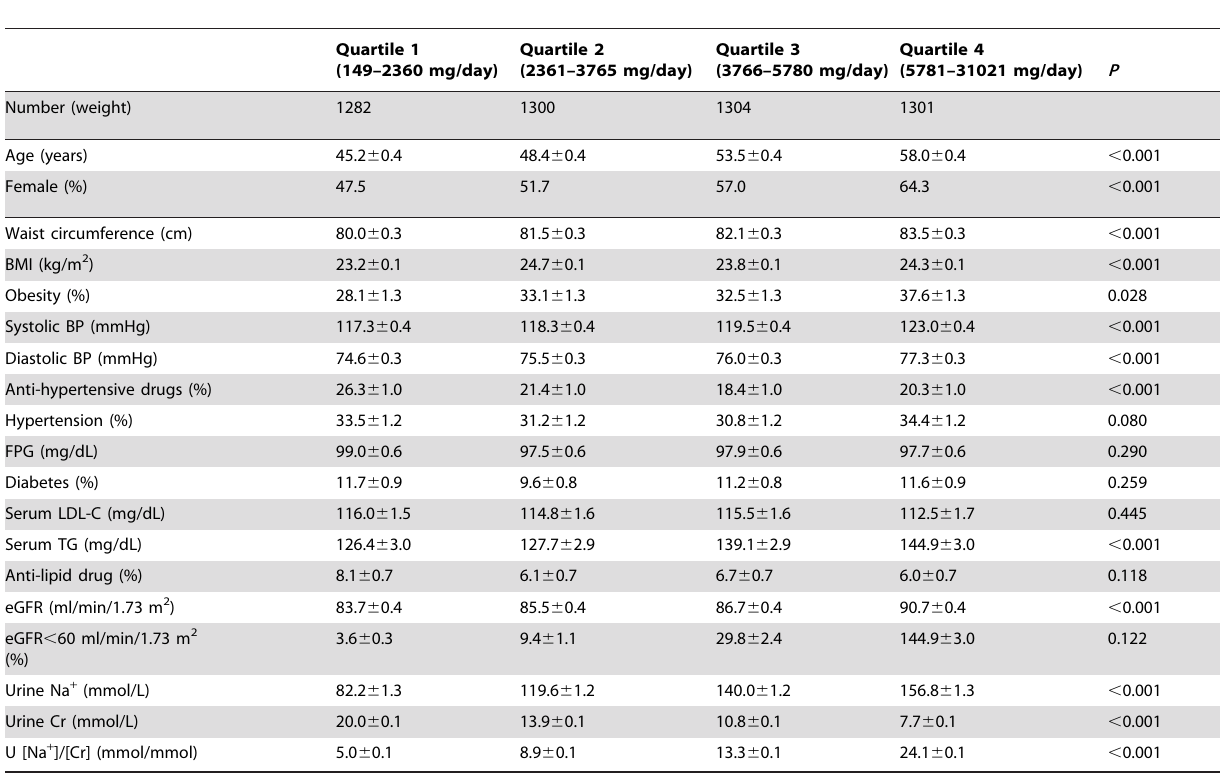
Table 2. Age, sex, and age- and sex-adjusted demographic and clinical characteristics of the Korean population, age 19 years and older, in the 2011 KNHANES based on the estimated 24-h urinary sodium